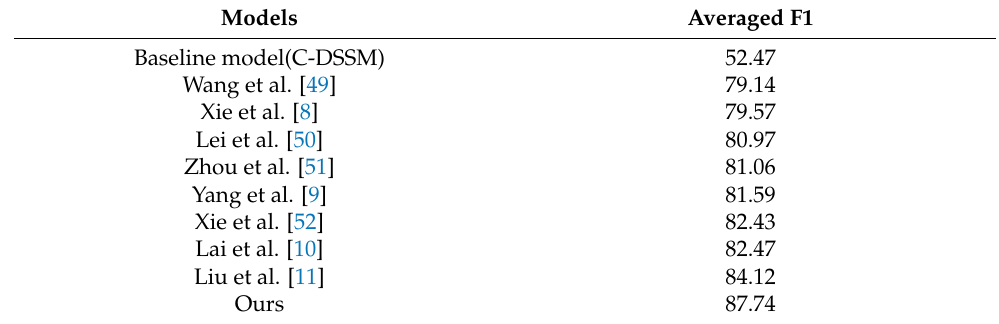
Table 7. NLPCC-ICCPOL 2016 KBQA result